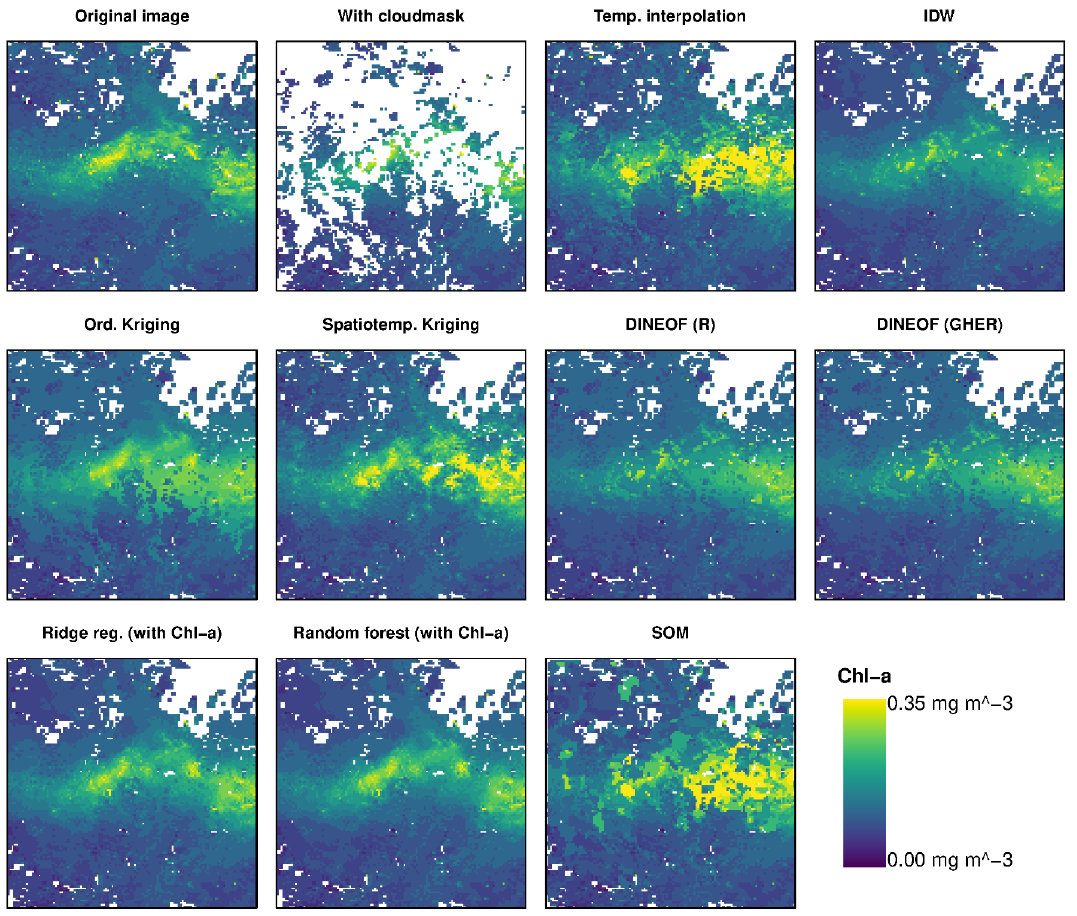
Figure 4. Example of a mostly cloud-free image in the Tropical Atlantic (8-day composite for 26 June–3 July, 2001), an added cloud mask, and reconstructions of pixels under the cloud mask. The plot labeled DINEOF (R) shows a reconstruction made with the unofficial R implementation, whereas the plot labeled DINEOF (GHER) shows a reconstruction made with the official DINEOF software. Only pixels under the cloud mask were reconstructed. All others are shown with their original values.